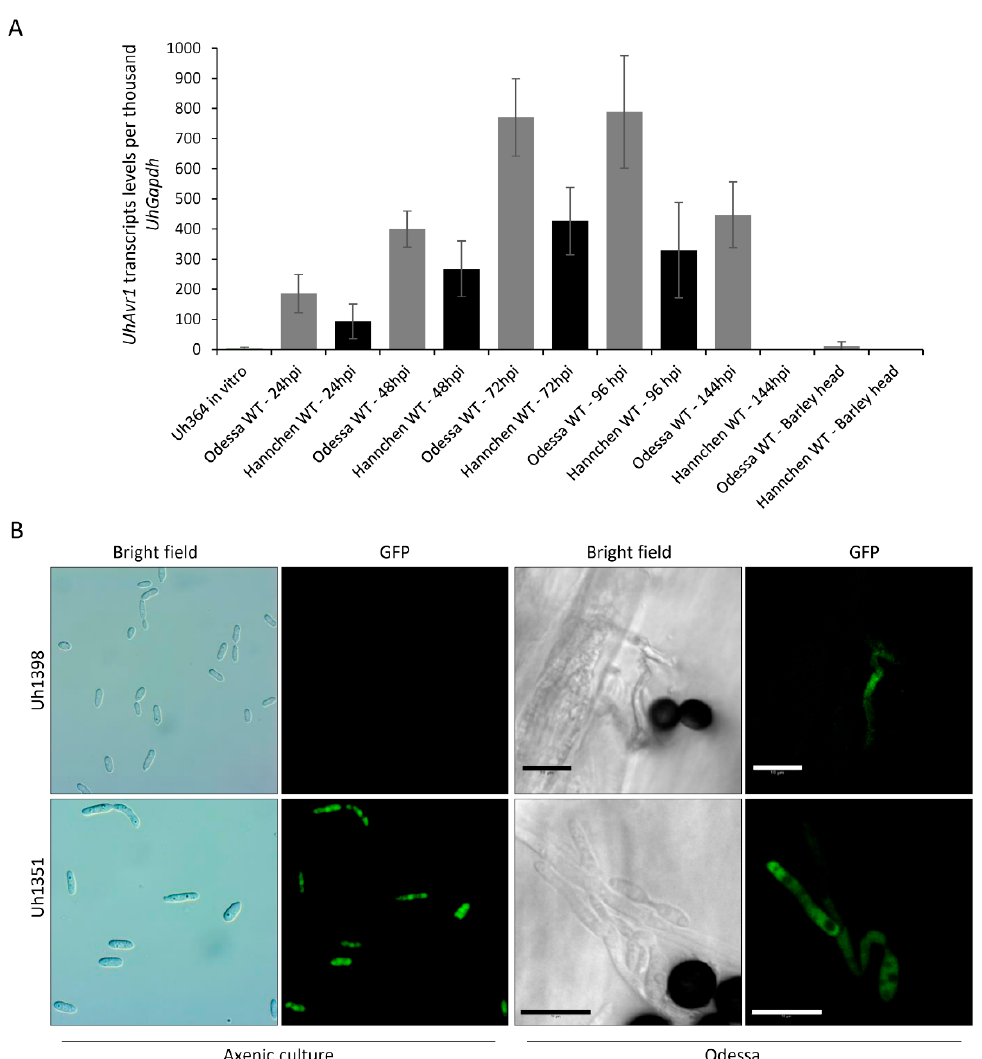
Figure 3. UhAvr1 expresses at the early stage of infection. ( A ) Expression of UhAvr1 in haploid cells and during the course of barley infection. Accumulation of UhAvr1 transcripts was measured in haploid cells grown in liquid medium, in seedlings inoculated with WT teliospores and in heads of cv. Hannchen and cv. Odessa. The graph shows the average from three independent biological repeats each consisting of three technical repeats for ddPCR. Values are expressed in number of UhAvr1 transcripts per 1000 reference gene UhGAPDH transcripts. Error bars represent the standard deviations calculated from the three biological repeats. ( B ) Microscopy images showing UhAVR1 expression upon host sensing. Haploid cells of strain Uh1351, constitutively expressing GFP, showed fluorescence while haploid strain Uh1398, expressing UhAvr1 -tagged GFP from its WT promoter (SP:GFP:UhAvr1), did not. Infection of cv. Odessa with teliospores from cross Uh362 ( MAT-2 Uhavr1 ) × Uh1351 ( MAT-1 UhAvr1 [otef:gfp] ), as well as SGUhAvr1 teliospores (from cross Uh362 ( MAT-2 Uhavr1 ) × Uh1398 ( MAT-1 ∆ UhAvr1 [ SP:GFP:UhAvr1 ])) , showed GFP fluorescence at 40 hpi. Microscopy of haploid strains grown in liquid media was done four times independently (Axioscope, Carl Zeiss); in barley, two independent repeats were performed. All confocal images are a snapshot from a single optical section and the scale bar represents 10 µ